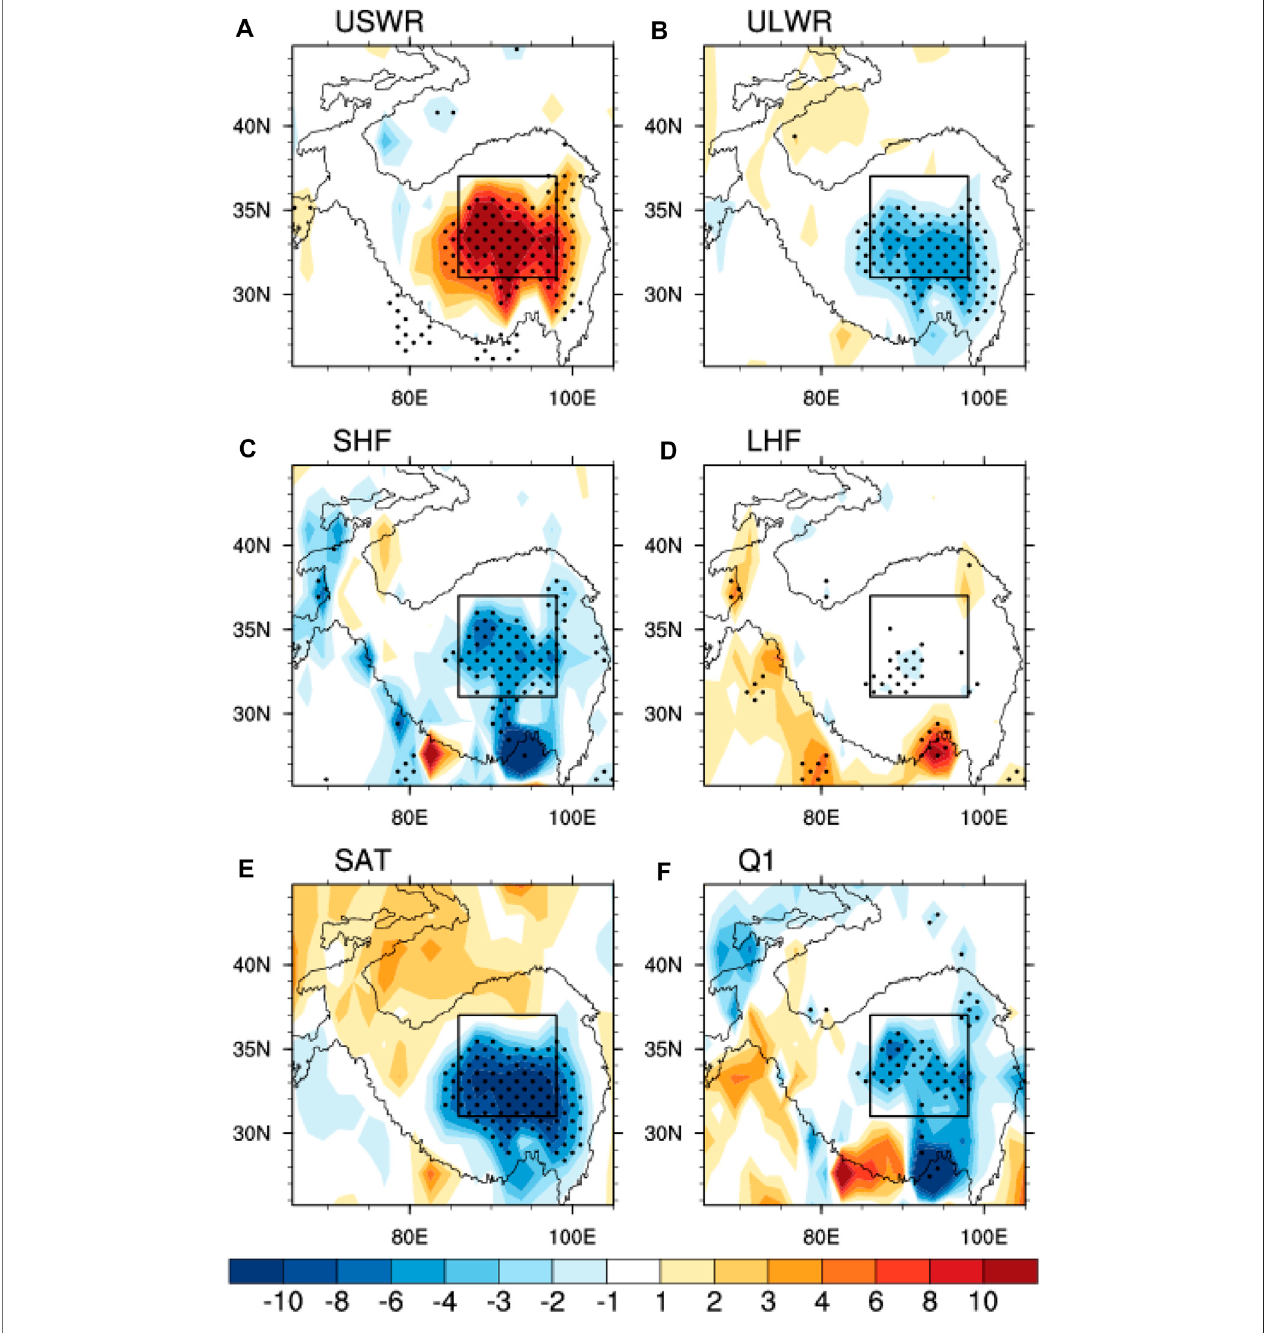
FIGURE 3 | Interannual anomalies of (A) upward shortwave radiation fl ux (Wm − 2 ), (B) upward longwave radiation fl ux (Wm − 2 ), (C) sensible heat fl ux (Wm − 2 ), (D) latent heat fl ux (Wm − 2 ), (E) surface air temperature ( × 10, ° C), and (F) Q 1 (Wm − 2 ) in ONDJ obtained by regression on the ONDJ TP SCI for the period 1979 – 1998. The dotted regions denote that anomalies are signi fi cantat the95% con fi dence level. Thebox denotes thekey region over theTibetanPlateau thatisused tode fi nethe SCI.